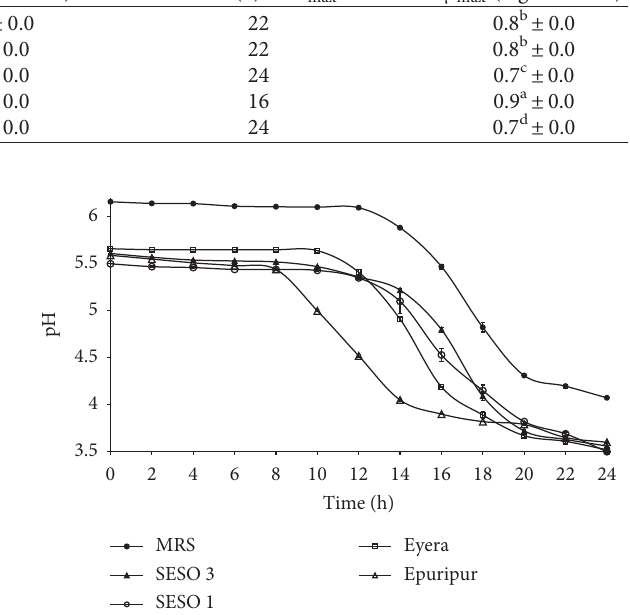
Figure 2: Free amino nitrogen utilization by L. plantarum MNC 21 in MRS broth and malt extracts from different sorghum varieties. Error bars show standard deviations of three independent fermentations.